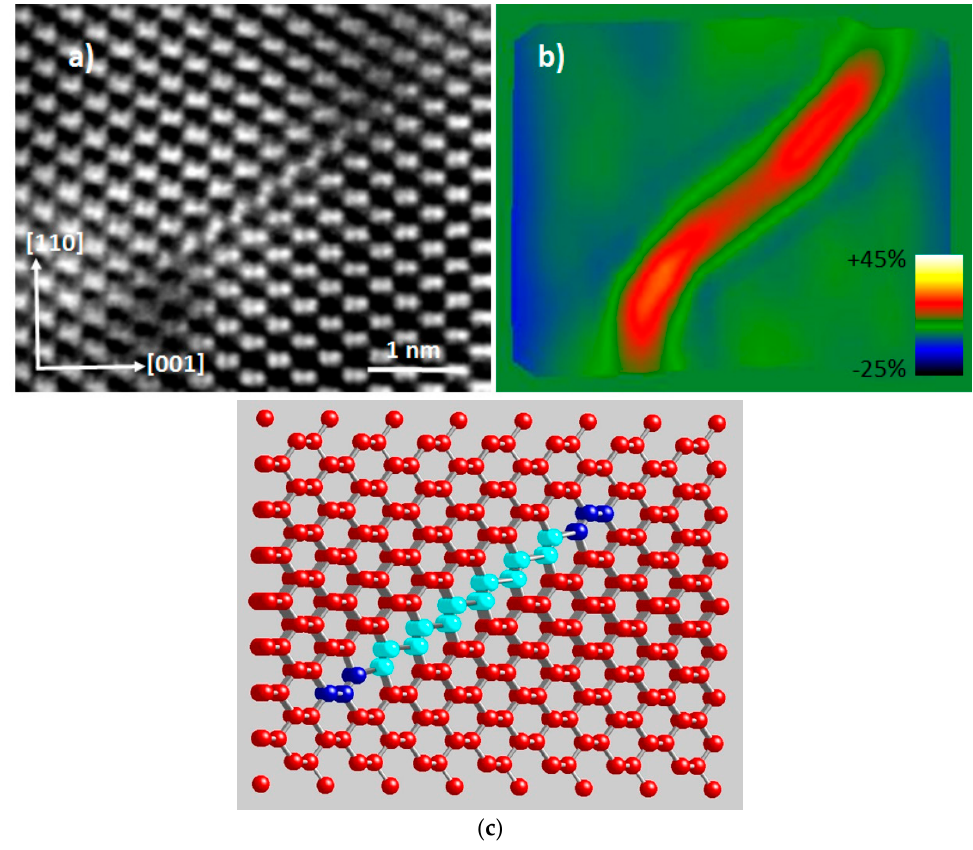
Figure 6. High-angle annular dark field electron microscope image of a dissociated screw dislocation ( a ). A {110} cross section sample was used for imaging. The resulting in-plane strain ( ε xy ) in the {110} plane is tensile ( ε xy ≅ 10%) and concentrated on the partial dislocations ( b ). The scale characterizes the strain in percent. Positive values denote tensile strain, while negative values are related to compressive strain. ( c ) Model of the atomic structure of the dissociated screw dislocation shown in ( a ). A red color characterizes atoms of the undisturbed silicon lattice, while dark blue color denotes atoms of the 30° partial dislocations, and light blue color indicates atoms in the stacking fault.